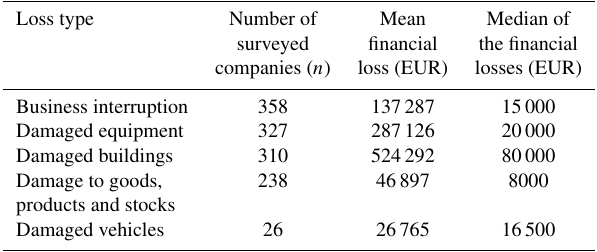
Table 3. Financial losses of companies affected by the flood in June